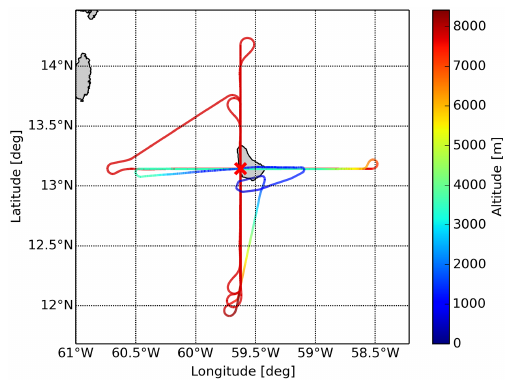
Figure 10. Track for the calibration flight on 26 June. The red cross indicates the position of the ground-based lidar